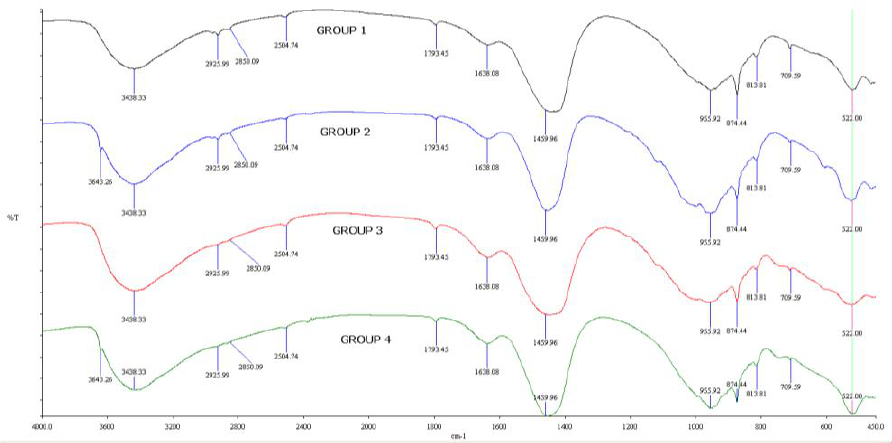
Figure 1. FTIR spectra of different types of cured Biodentin showing the absorbance peaks of the precipitates of each modified biodentin. Absorbance peaks ranging from 474.63 cm − 1 to 3643.26 cm − 1 are seen.